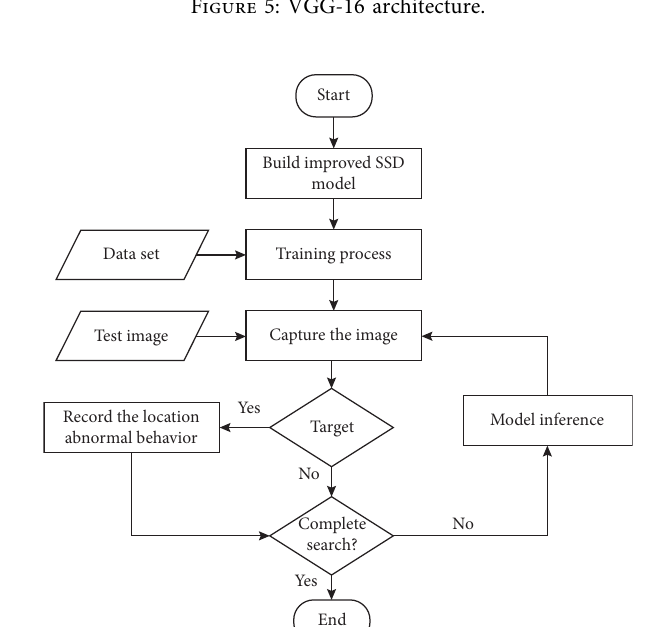
Figure 5: VGG-16